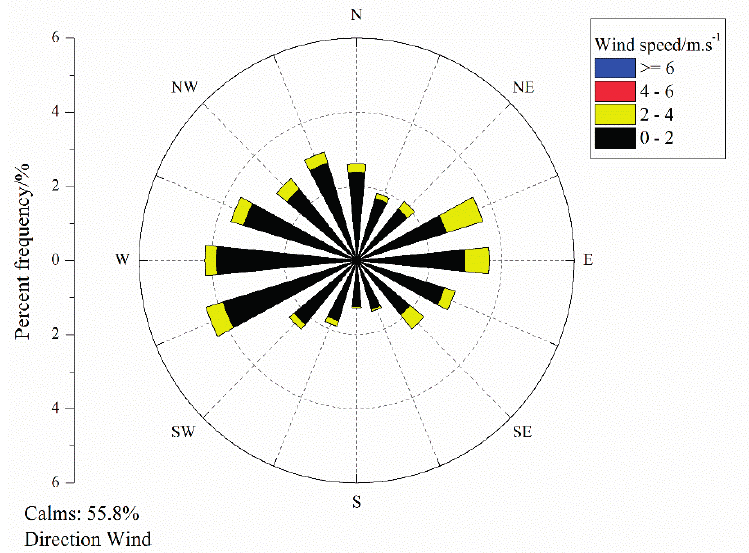
Figure 2. Wind direction and wind speed frequencies during the sampling period.